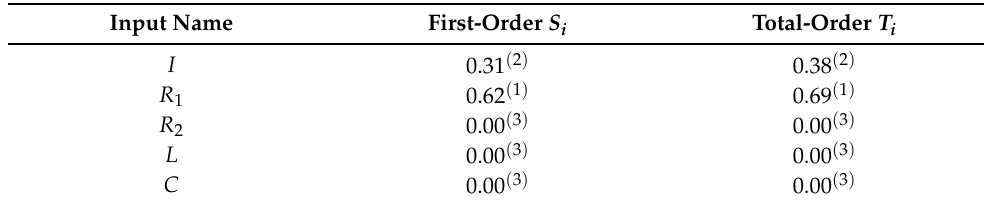
Table 6. First- and total-order Sobol indices for I , R 1 , R 2 , L , C at the steady state ( t = 40 ms). The cor- responding rankings of the model inputs are reported in parenthesis. Analysis of this table provides the answers to Questions 1 and 2.